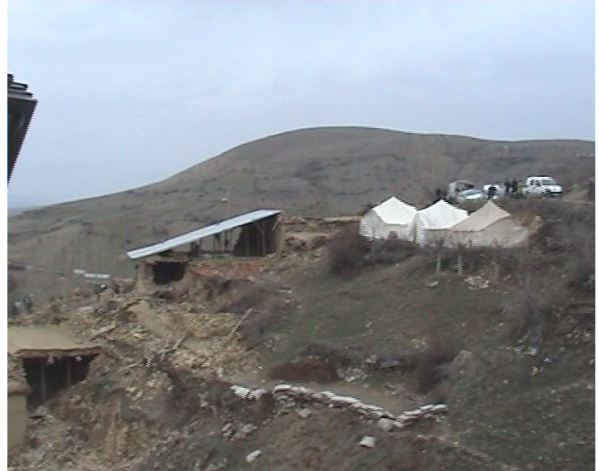
Fig. 11. Damaged buildings on a hill with high